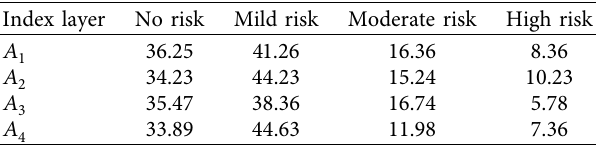
Table 4: Evaluation results of the index